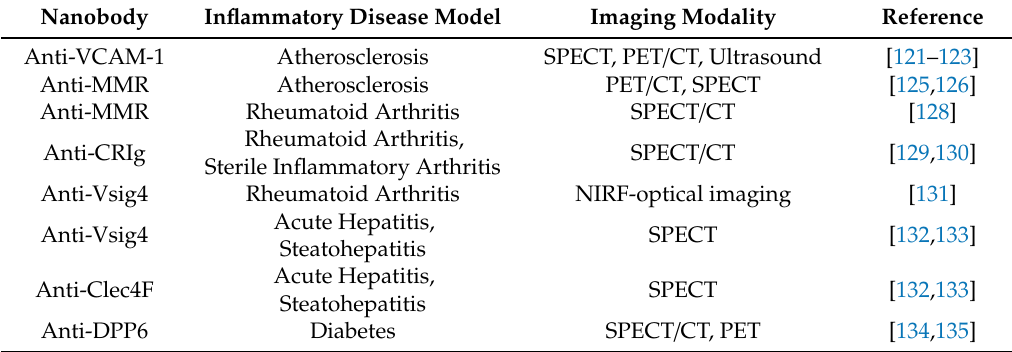
Table 1. Overview of Nb-based tracers for molecular imaging of inflammatory